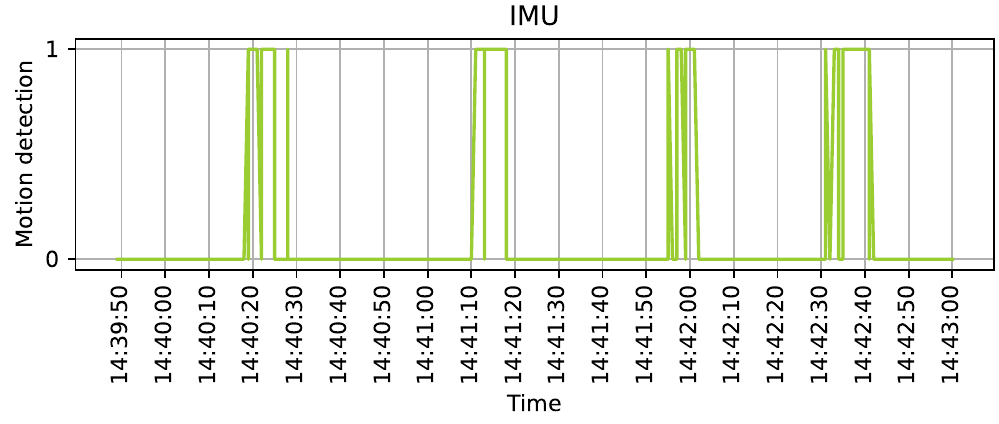
Figure 13. Inertial Measurement Unit (IMU) triggers the system by setting "1" its